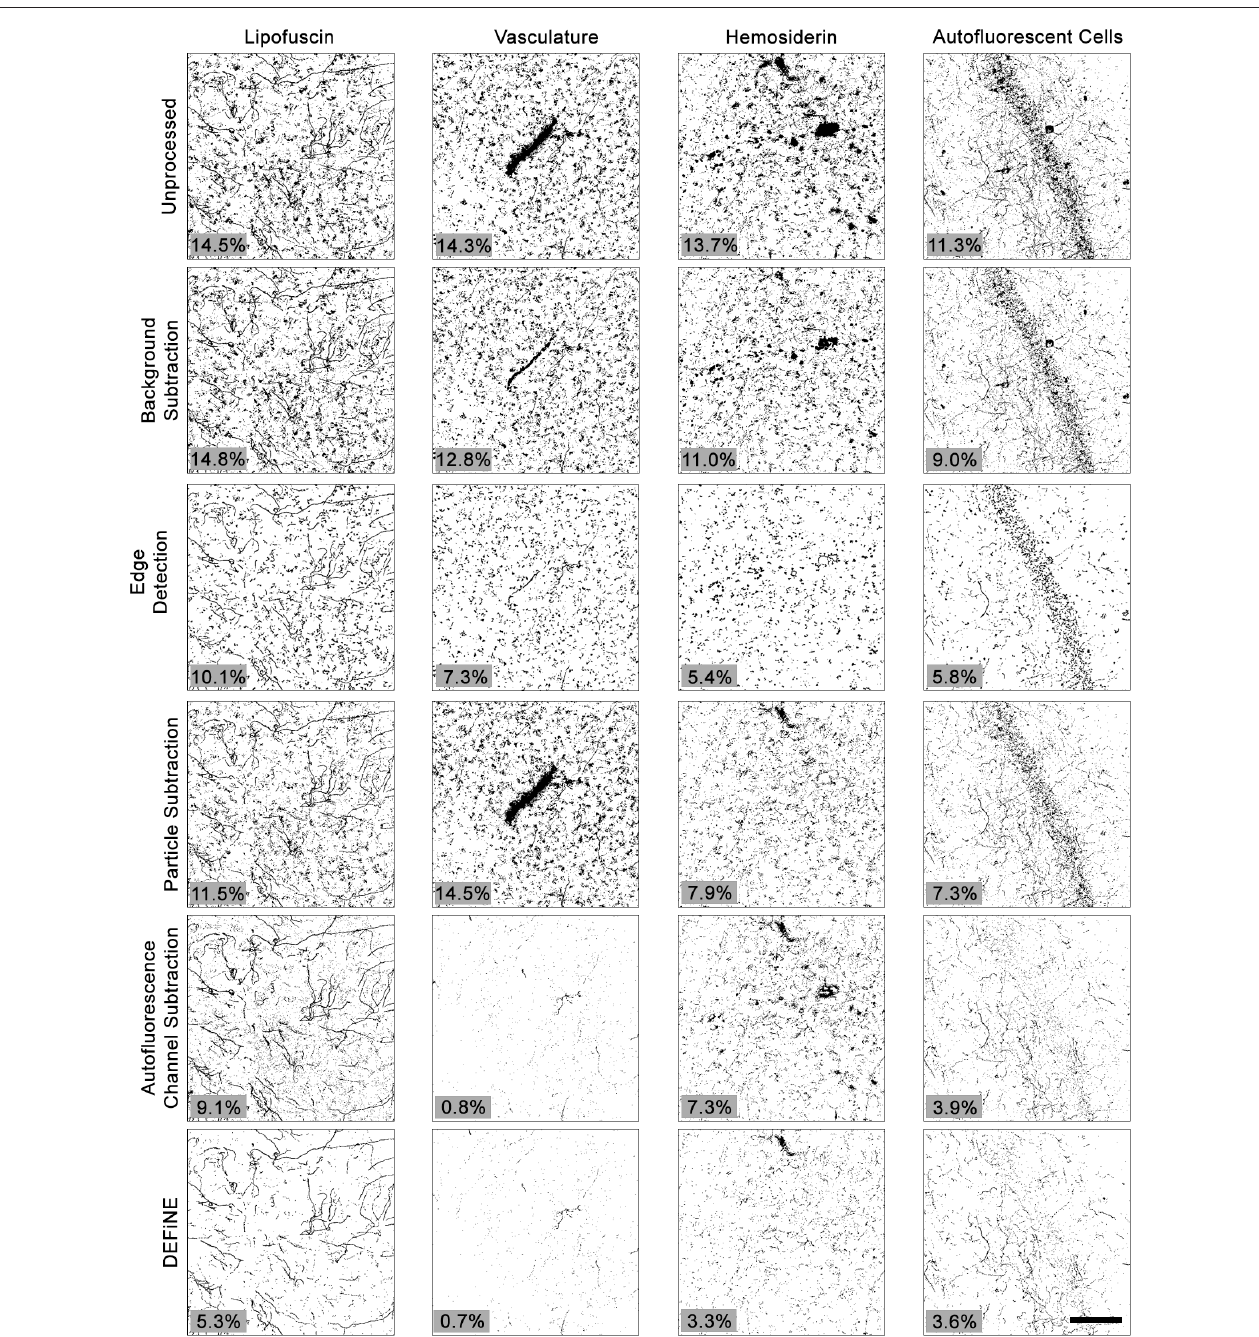
FIGURE 6 | The full DEFiNE process eliminates more fluorescent artifacts than alternate methods for removing background or selecting axonal fibers. Binary images generated by DEFiNE’s Quantify Fibers function show axons and fluorescent artifacts in unprocessed images and after rolling-ball background subtraction (FIJI), Hessian-based edge detection (Grider et al., 2006), morphology-based particle subtraction, autofluorescence channel subtraction, or DEFiNE. The fluorescent signal remaining after processing (black pixels) is indicated as a percentage of the total image area (lower left of each panel). Scale bar: 100 µ m.